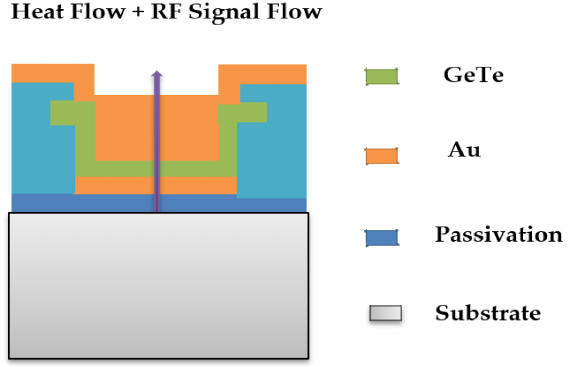
Figure 4. Device layout for a two terminal directly heated GeTe based RF switch.